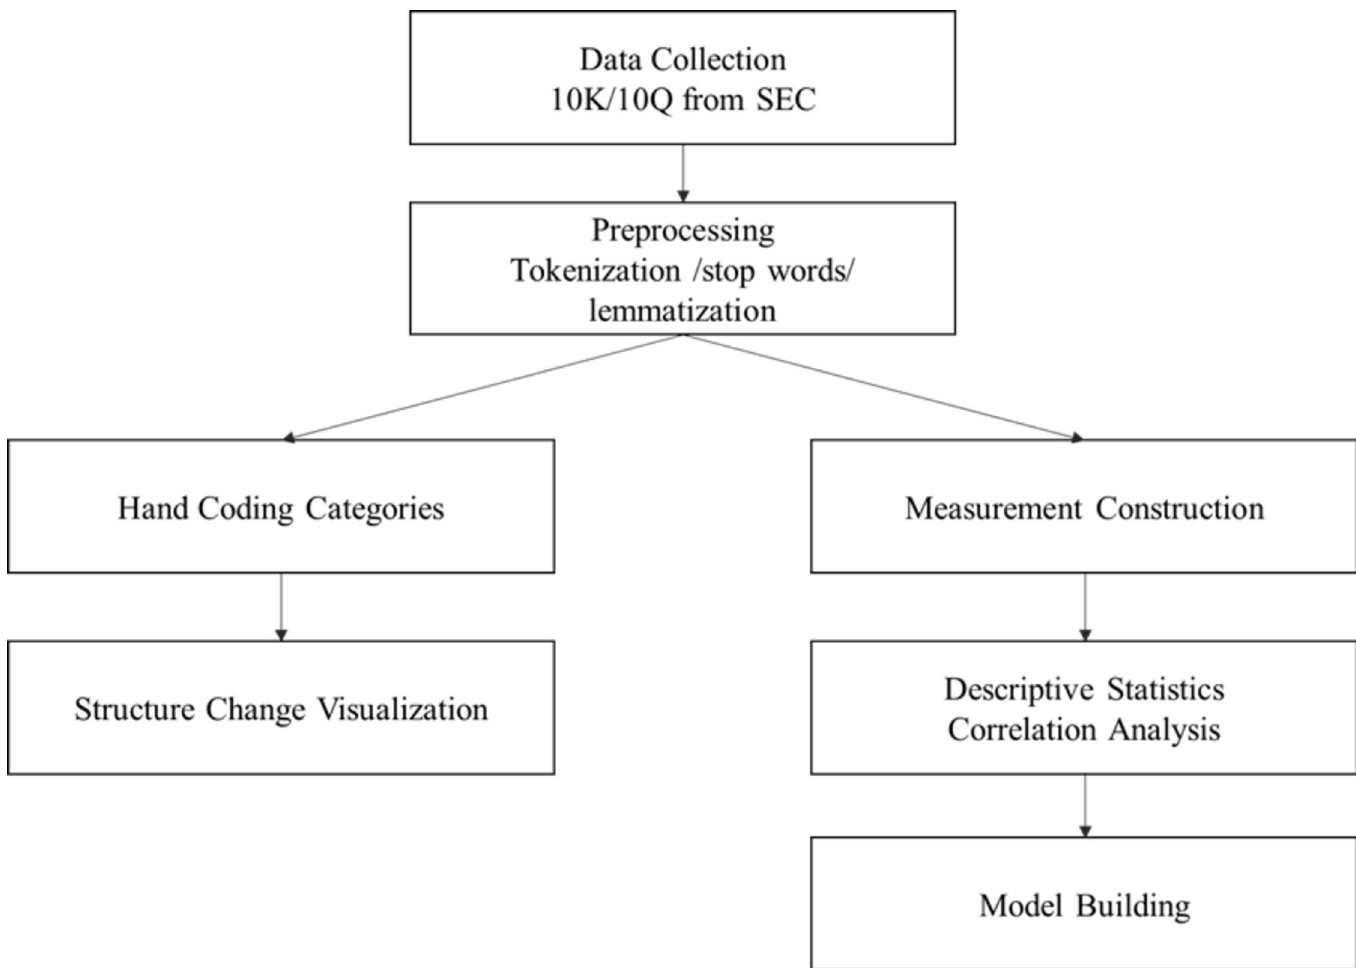
Fig 2. Flow chart of